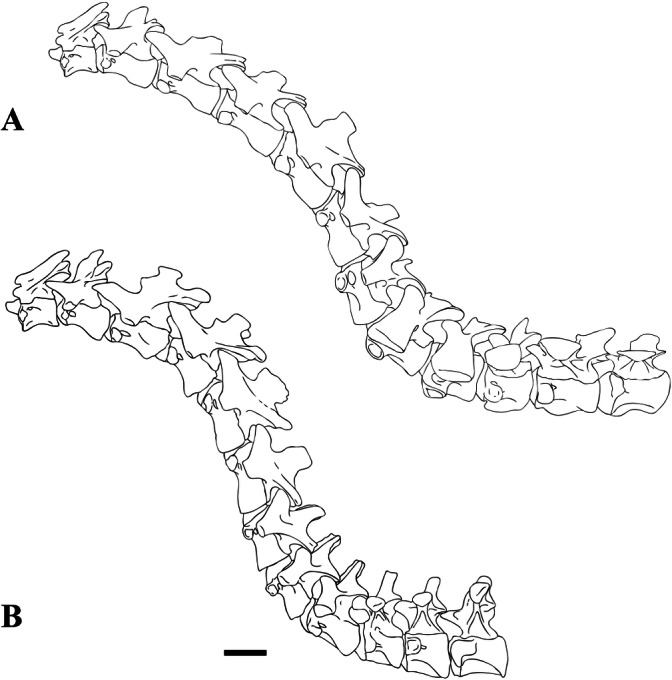
Neck reconstructions of Sigilmassasaurus and Baryonyx.(A) Sigilmassasaurus; (B) Baryonyx. Scale bar equals 10 cm. Scale bar only applies to Baryonyx, for which associated material is preserved. Reconstructions are based on the holotype material for Baryonyx, and material discussed in this paper for Sigilmassasaurus. Note that the first vertebra depicted is the C2 (axis), and that reconstruction includes anterior dorsal vertebrae.